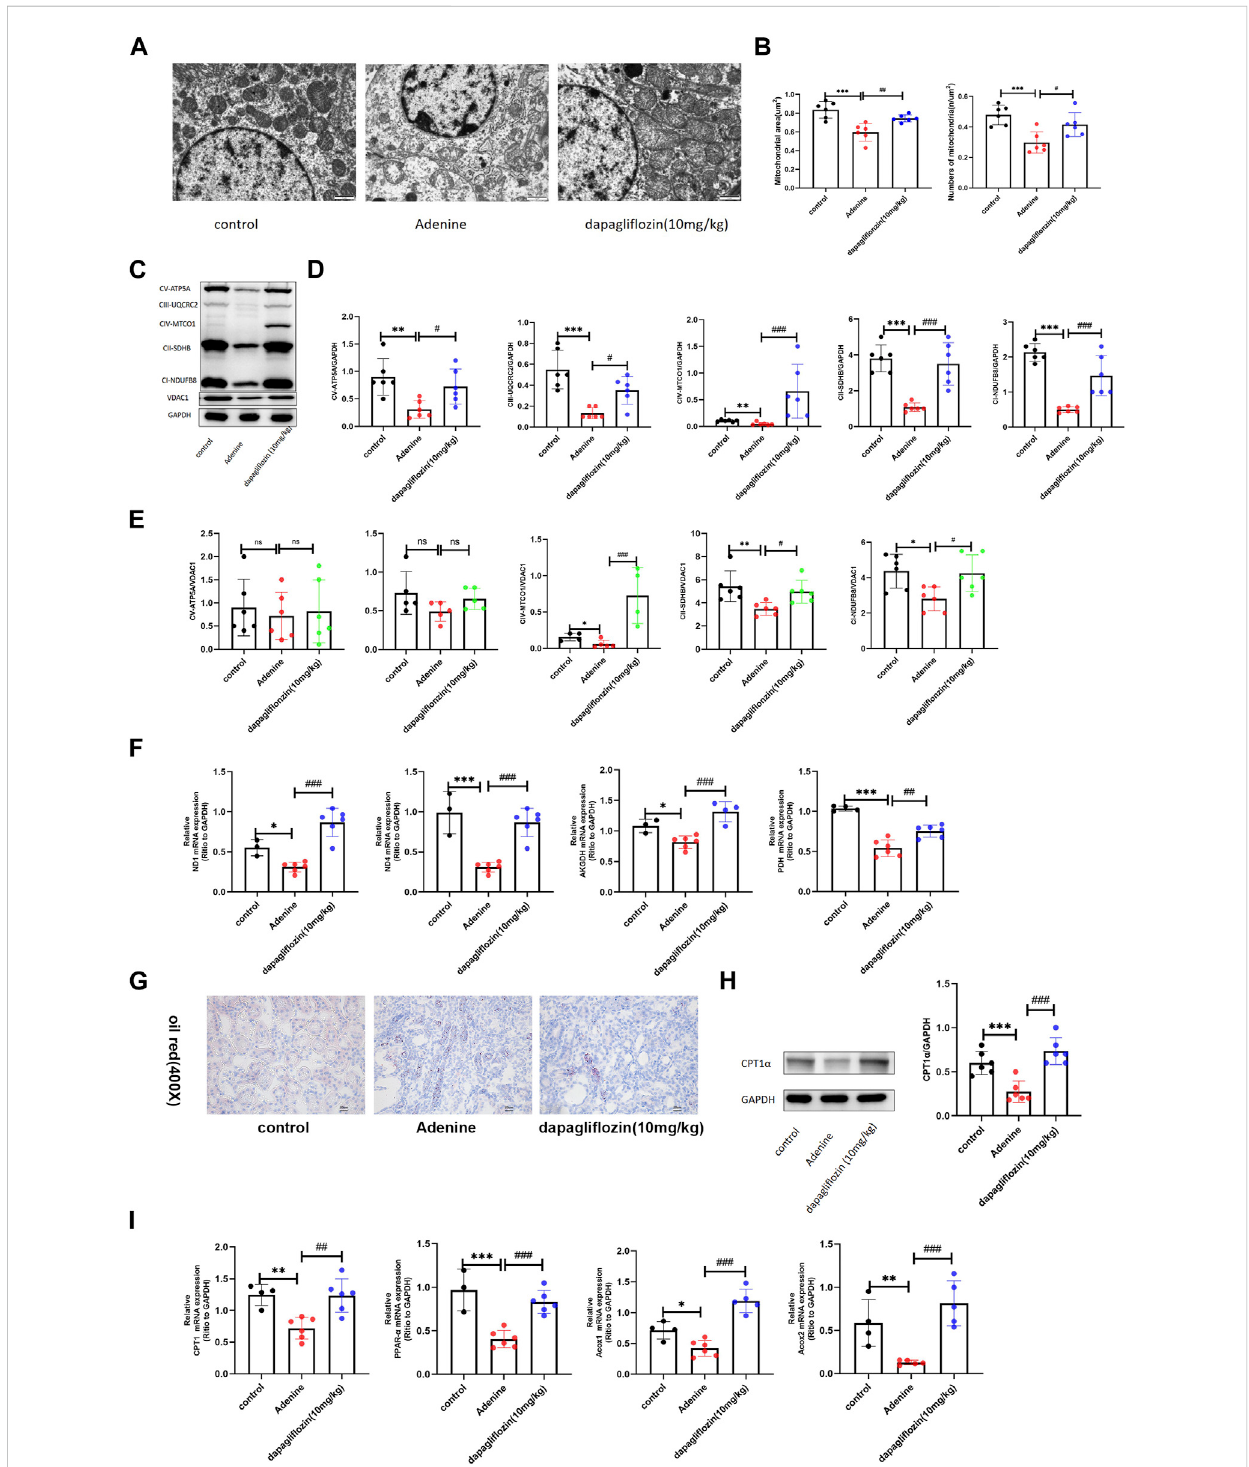
FIGURE 4 Dapagli fl ozin increased the levels of mitochondrial metabolism and fatty acid oxidation in 0.2% adenine diet-fed mice. (A) Mitochondrial morphologyof renal tubularepithelial cellswas examinedusing transmission electron microscopy.Scalebars, 1 μ m. (B) Mitochondrialareasand amount in renal tubular cell of each group. (C – E) Western blot showing the expression of mitochondrial respiratory chain complexes (oxphos) in the renal tissue ofeachgroup. (F) RealtimePCRshowingtheexpressionofmitochondrialmetabolism-relatedgenesND1,ND4,AKGDH,andPDHintherenaltissue ofeachgroup. (G) Renaloilredstainingofeachgroup.Scalebars,20 μ m. (H) WesternblotshowingtheexpressionofCPT-1 α ofintherenaltissueofeach group. (I) Real time PCR showing the expression of fatty acid oxidation-related genes CPT1, PPAR- α , ACOX1, and ACOX2 in the renal tissue of each group. Values are means ± SD.* p < 0.05 adenine diet group compared with the control group; ** p < 0.01 adenine diet group compared with the control group;*** p < 0.001adeninedietgroupcomparedwiththecontrolgroup; # p < 0.01dapagli fl ozintreatmentgroupcomparedwiththeadeninedietgroup; ## p < 0.01 dapagli fl ozin treatment group compared with the adenine diet group; ### p < 0.001 dapagli fl ozin treatment group compared with the adenine diet